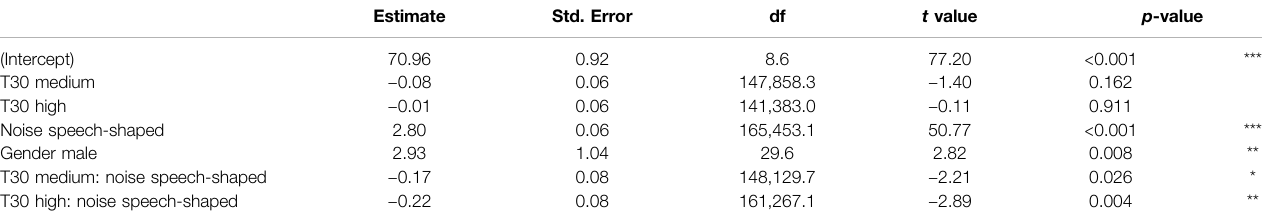
TABLE 6 | LME models fi t by REML for the response variable SPL and the fi xed factors 1) T30, 2) noise, 3) gender, and 4) the interaction between T30 and noise. Estimate